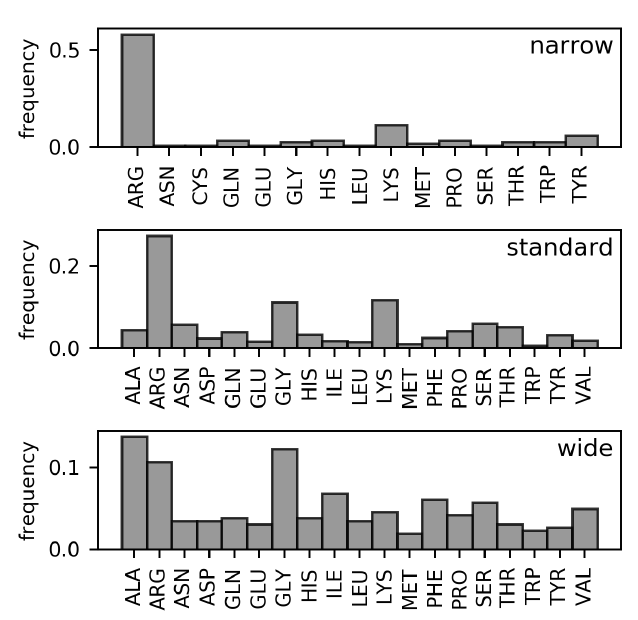
Figure 3. Frequencies of amino acids contacting narrow, standard, and wide DNA minor grooves (DS2